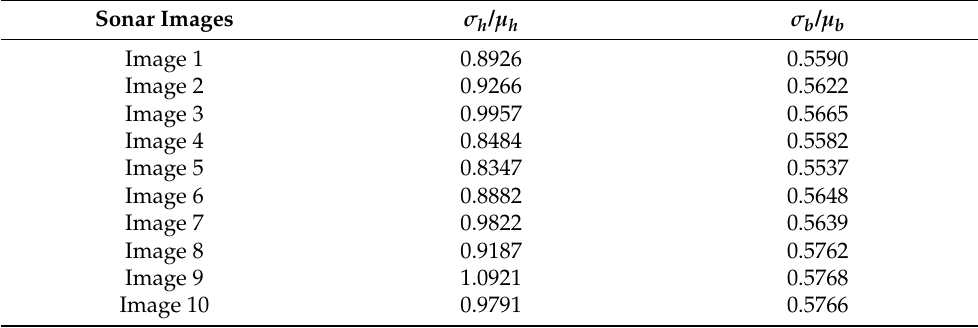
Table 1. Ratios of mean and deviation of highlight areas and seafloor reverberation areas in 10 sonar